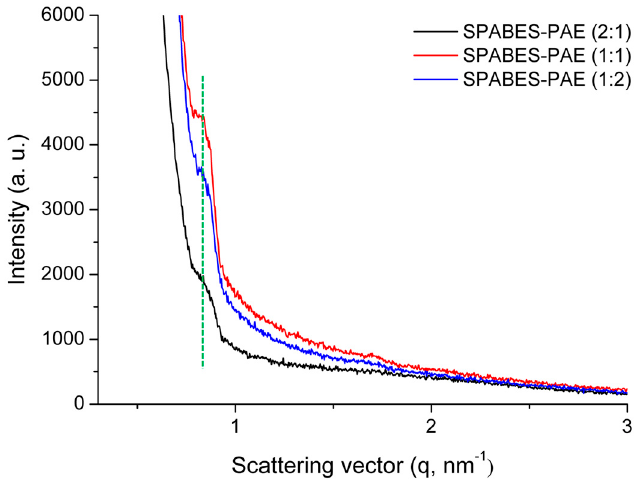
Figure 9. The SAXS patterns of SPABES-PAE membranes under a fully hydrated state. Table 6. The scattering vector (q max ) and ion cluster size of SPABES-PAE membranes.